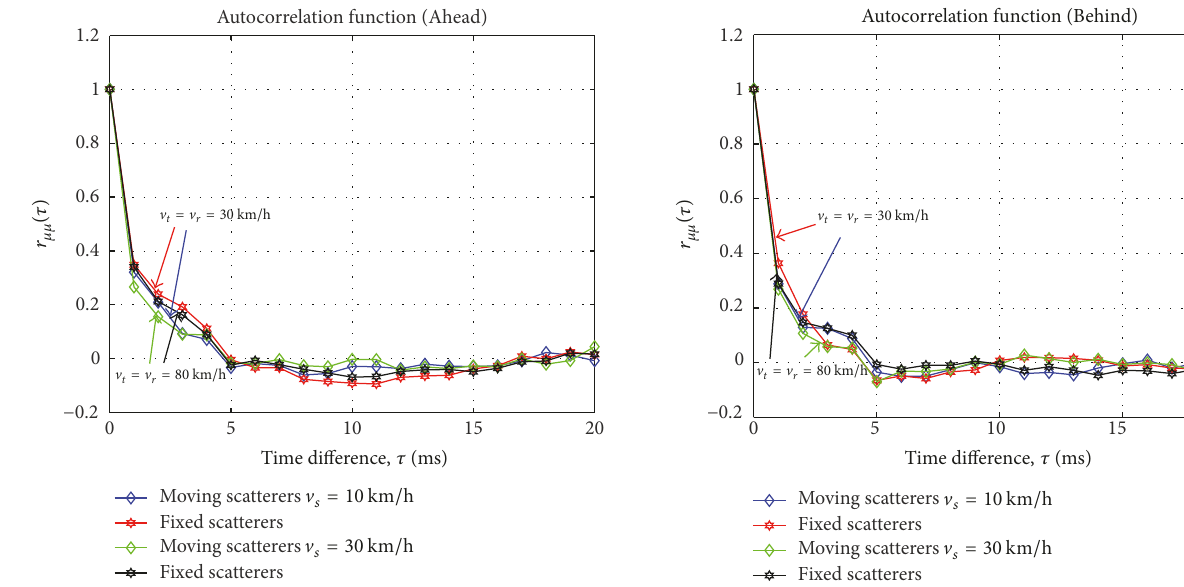
Figure 11: Behavior of ACF 𝑟 𝜇𝜇 (𝜏) presented in Figure 3(c) for V2V scenarios (“Behind” central angle: 𝜃 𝑡 = 120 ∘ , 𝜃 𝑟 = 150 ∘ uniform